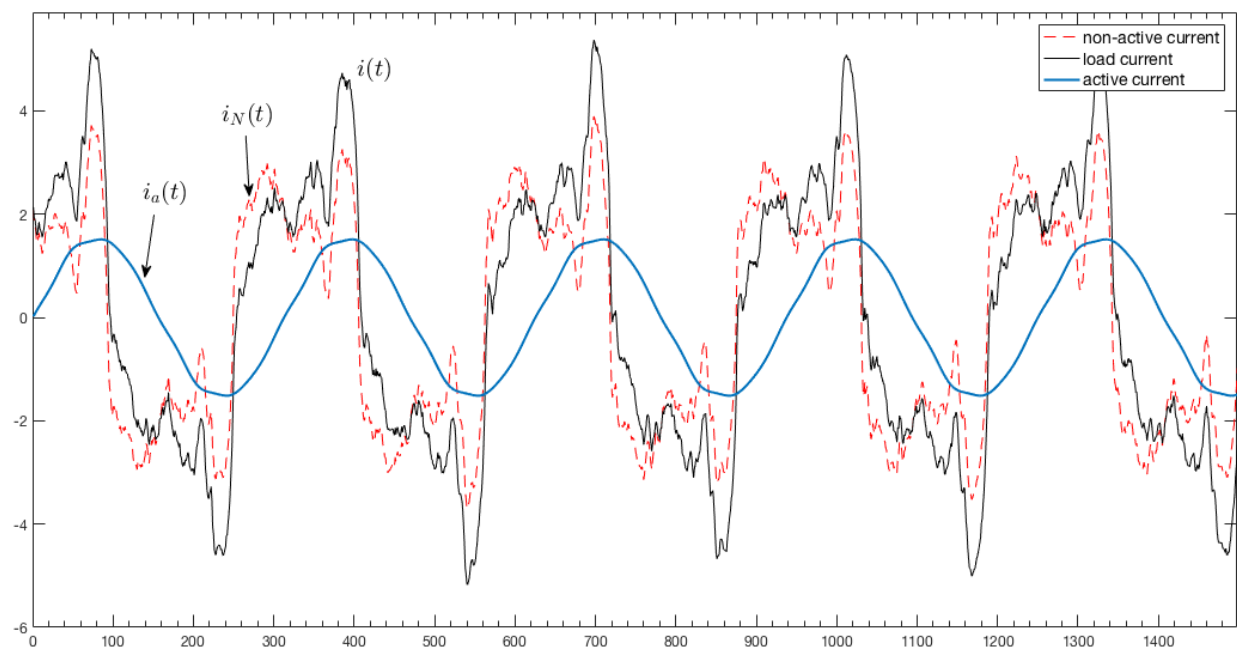
Figure 6. Total, active and non-active current for the